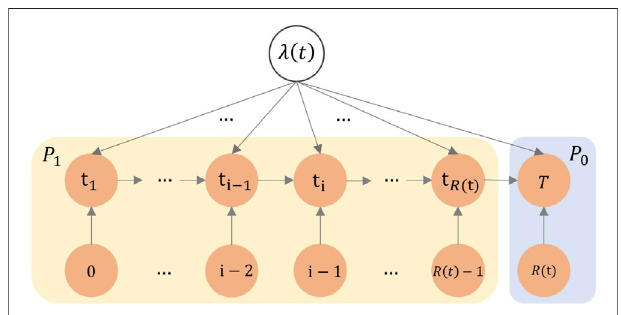
FIGURE2| Graphicalrepresentationofthemodelforthearrivalprocess.